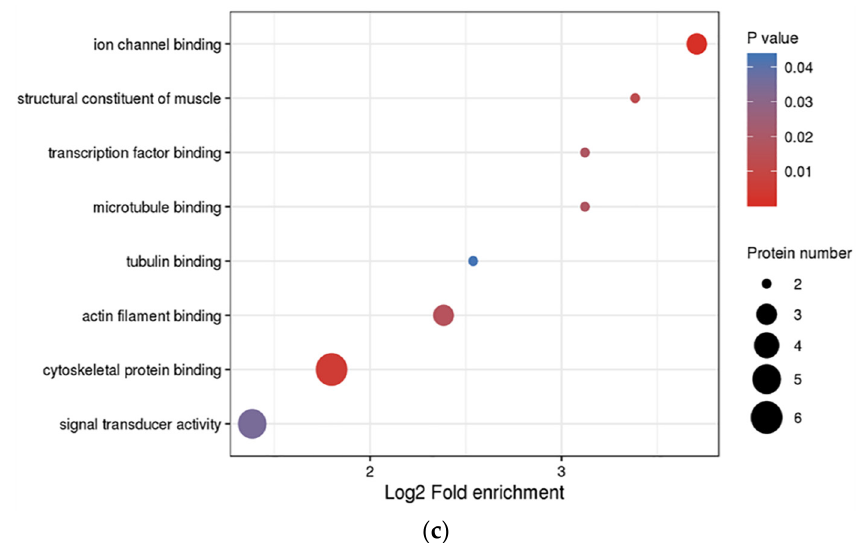
Figure 4. GO enrichment shown in the bubble plot of 24 DEPs in three categories: ( a ) biological process; ( b ) cellular component; ( c ) molecular function. For the enrichment test (Fisher’s exact test was used here), resuls show the most significant top 20 classifications. The y -axis denotes function classification, and the x -axis denotes the log2 converted value of the fold change. The significance of enrichment p -values is represented by colors. The circle size signifies the number of DEPs in each functional class or pathway.